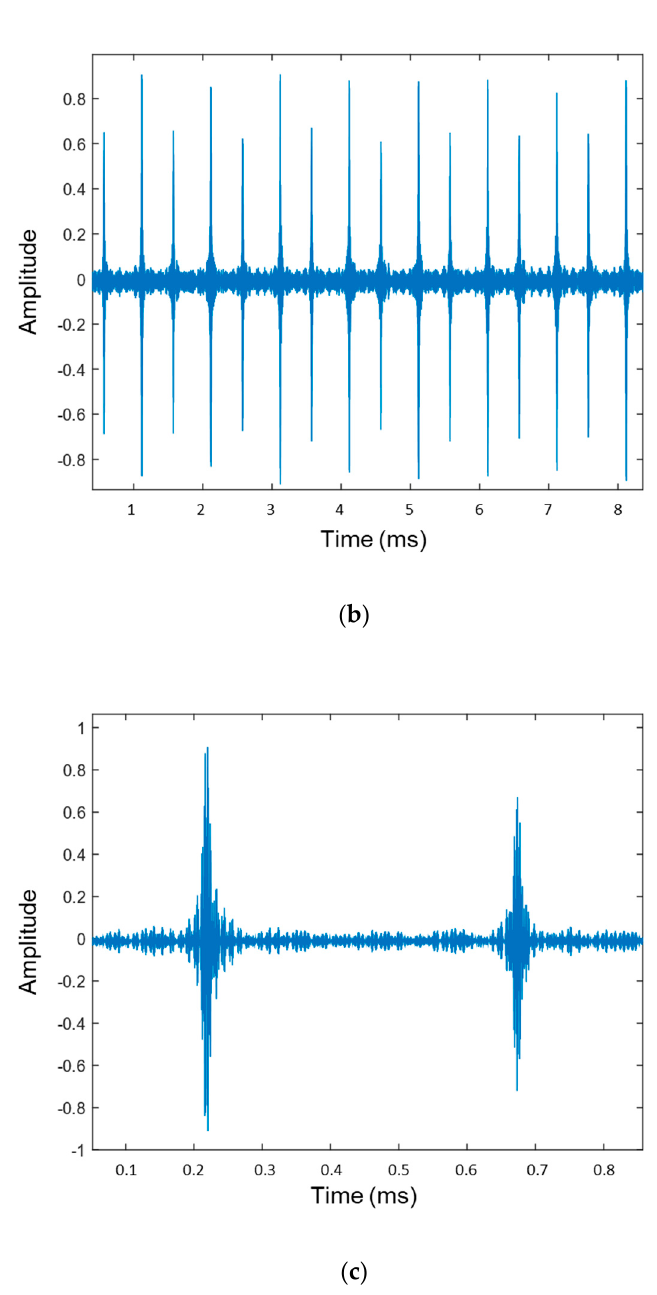
Figure 11. Received signal on the 15 m test: ( a ) Received signal for the 800 → 900 kHz chirp; ( b ) Cross-correlation result from signal received; ( c ) Zoom of the Cross-correlation result.